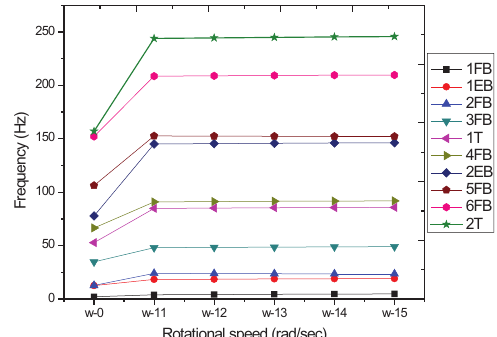
Figure 10. Trend of first ten modes with lift and gravity forces